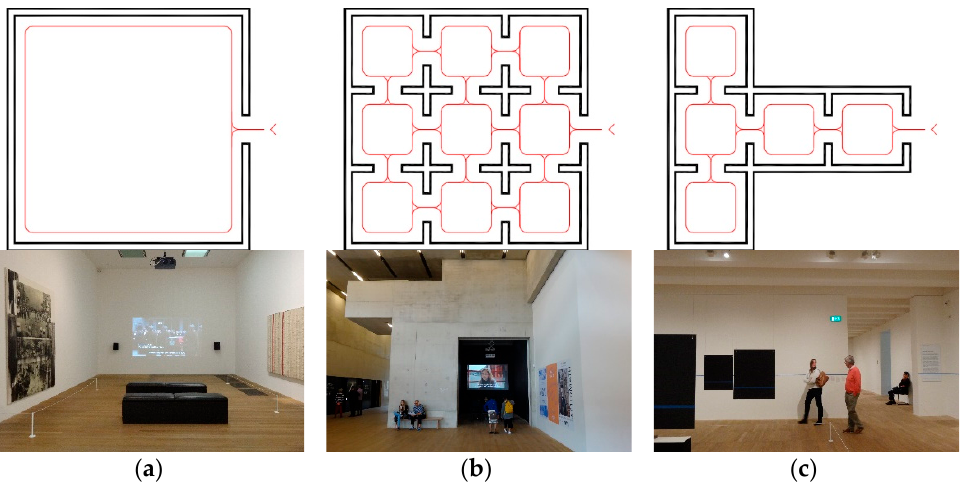
Figure 2. Configurations of space type. ( a ) single; ( b ) multiple; ( c ) sequential.